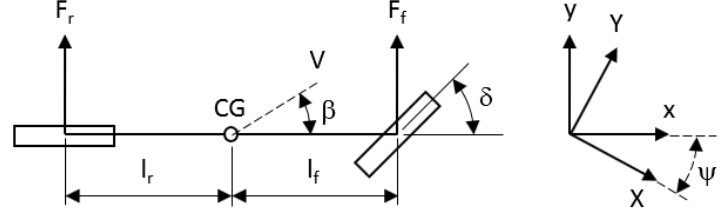
Figure 3. Simplified bicycle model for lateral